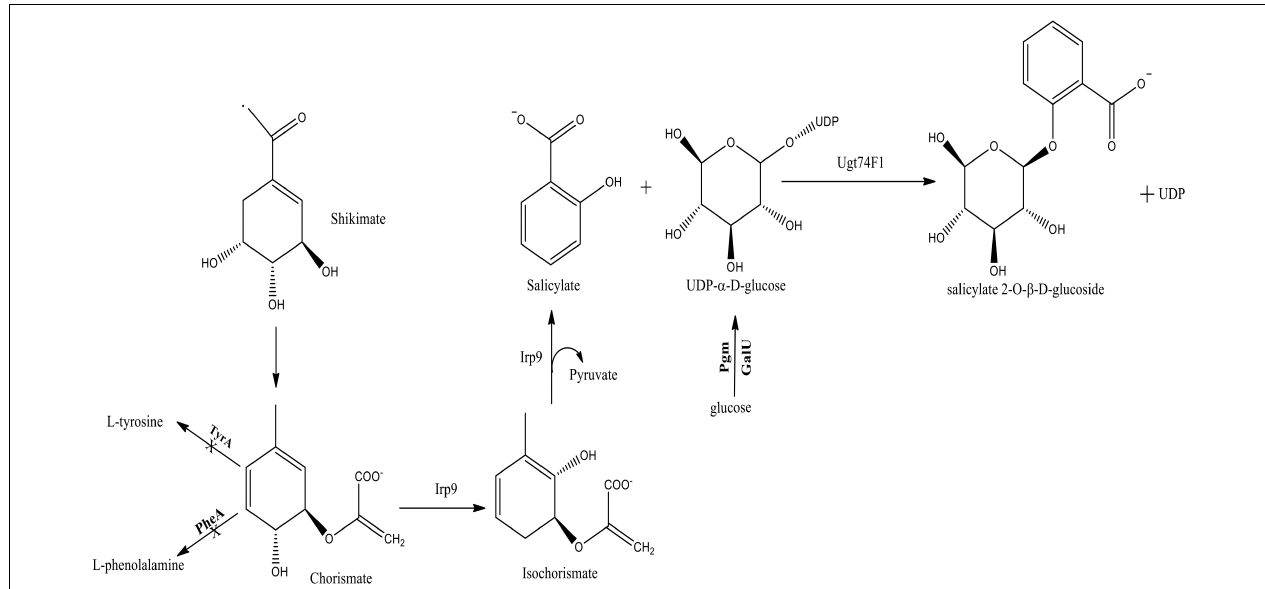
FIGURE 1 | The native and heterologous metabolic pathway for salicylate 2-O- β -D-glucoside (SAG) biosynthesis established within E. coli . The native TyrA, PheA, Pgm, and GalU steps were either deleted or over-expressed (bold); whereas the heterologous Irp9 and Ugt74F1 steps were introduced from Yersinia enterocolitica and Arabidopsis thaliana ,